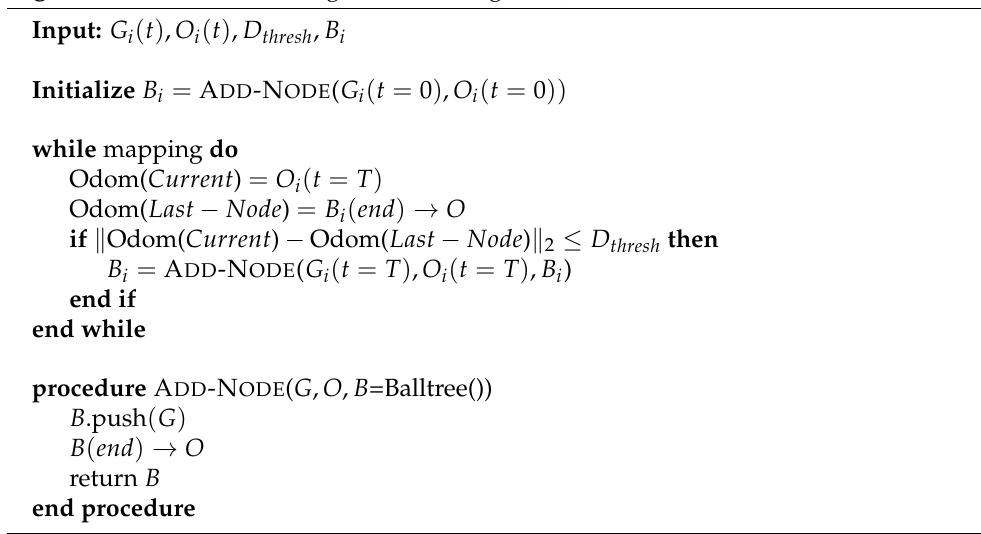
Algorithm 1 Global ball-tree generator for agent R i